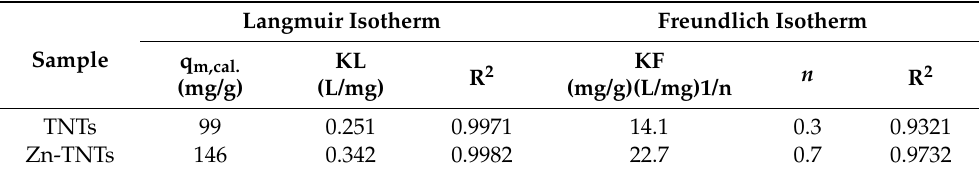
Table 2. Langmuir and Freundlich isotherm constants for RhB uptake on TNTs and Zn-TNTs.